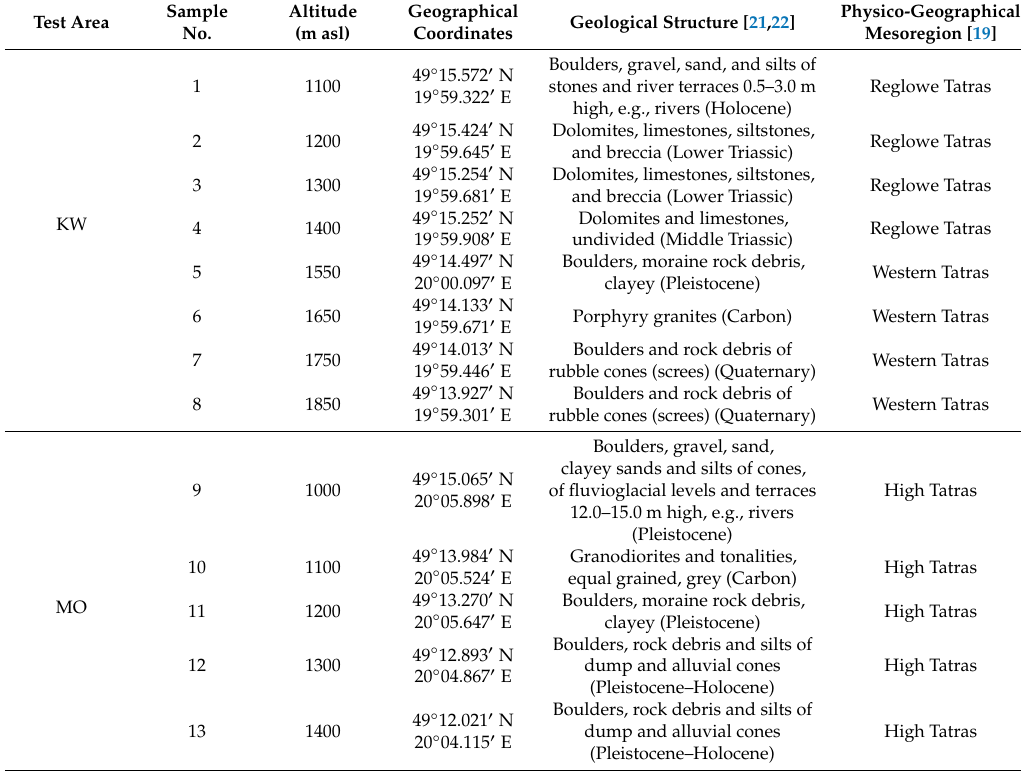
Table 1. Selected characteristics of soil sampling points in the Kasprowy Wierch (KW) and Morskie Oko (MO) tested